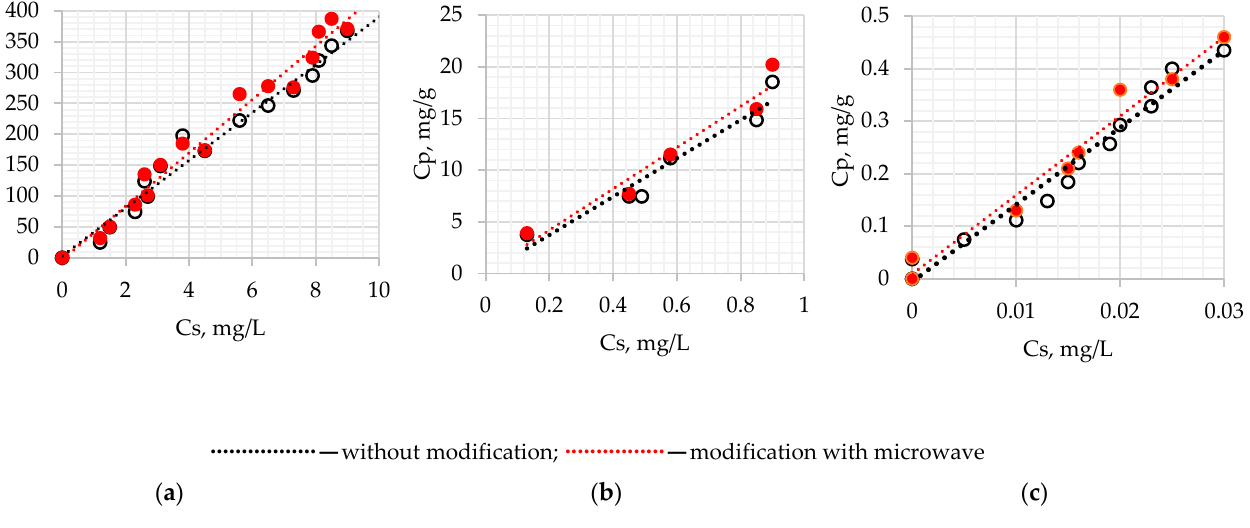
Figure 1. Sorption isotherms of oil products by peat obtained from aqueous solutions at initial concentration, mg/L, of ( a ) 250, ( b ) 50, and ( c ) 0.5.